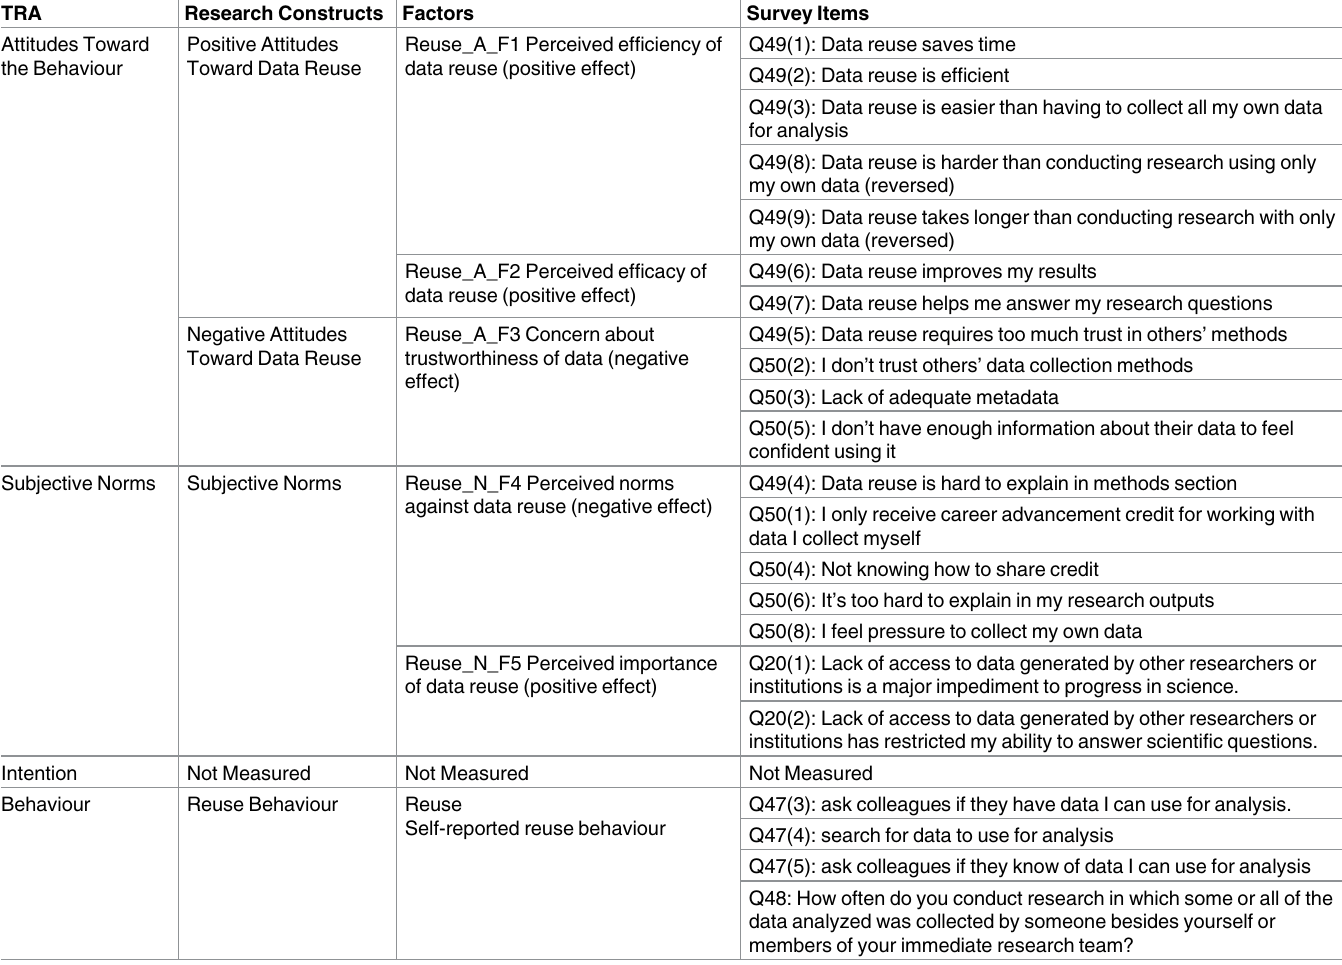
Table 3. Relationship between TRA and researchconstructs.